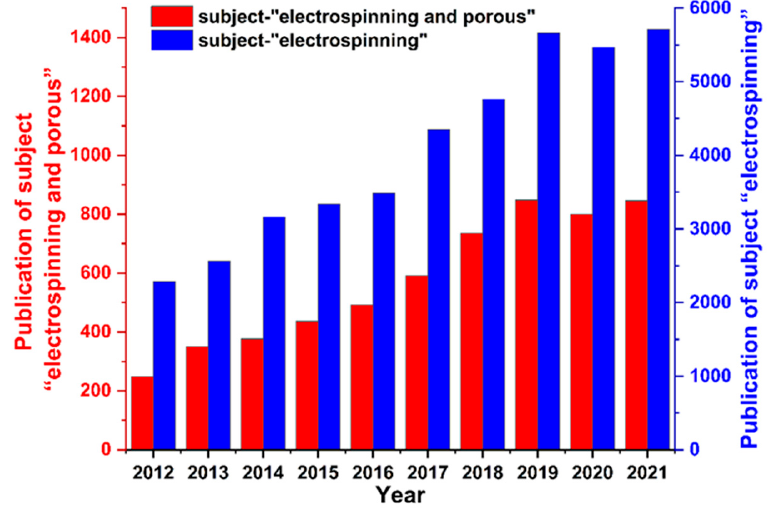
Figure 1. Research status of electrospinning porous nanofibers.